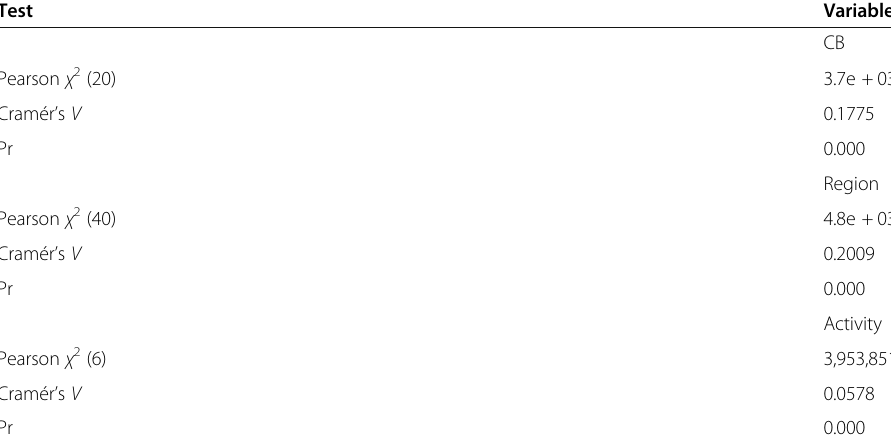
Table 5 Results of the independence test between control outcome and dependent variables